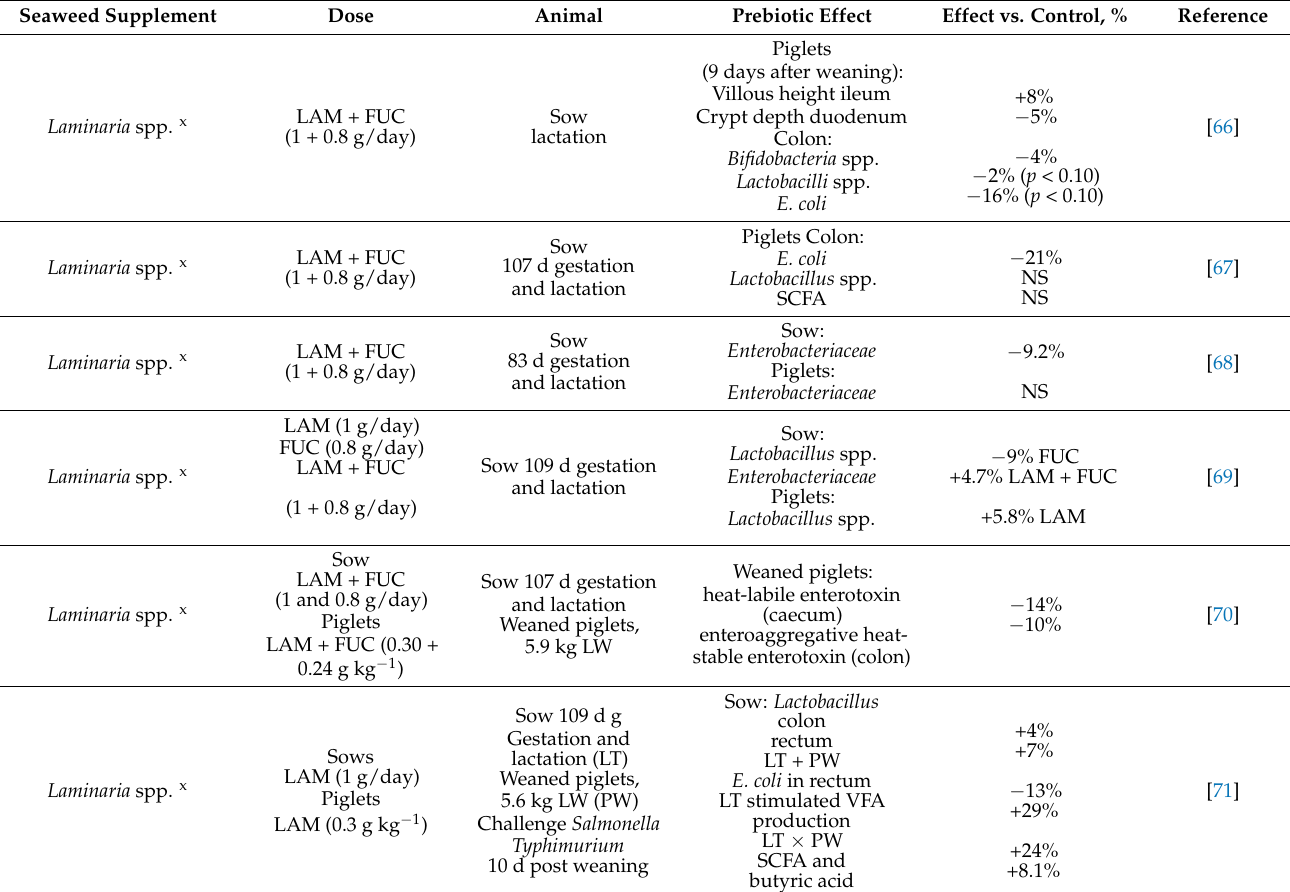
Table 3. Prebiotic effects of brown seaweed in